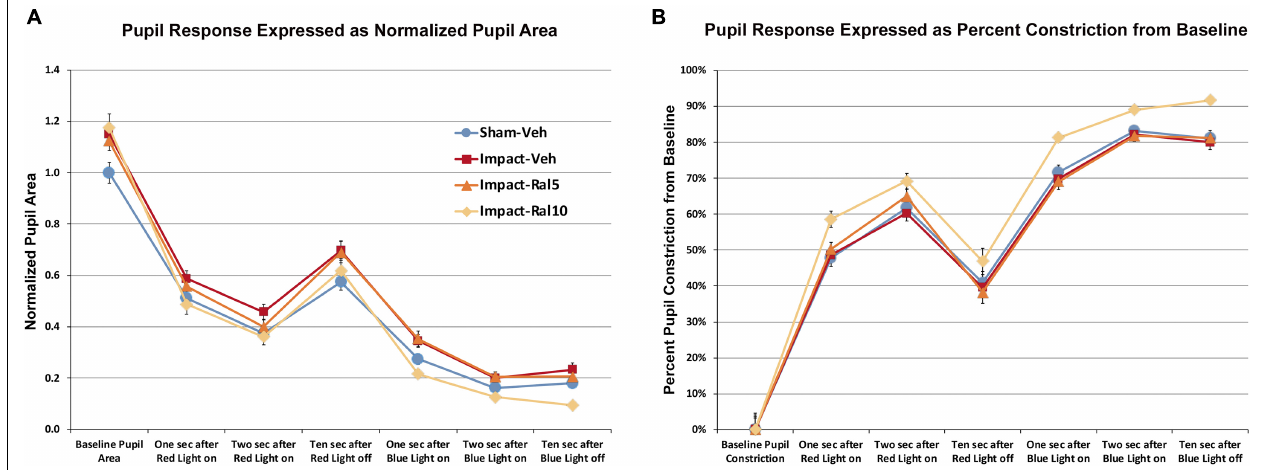
Frontiers in Neuroscience |